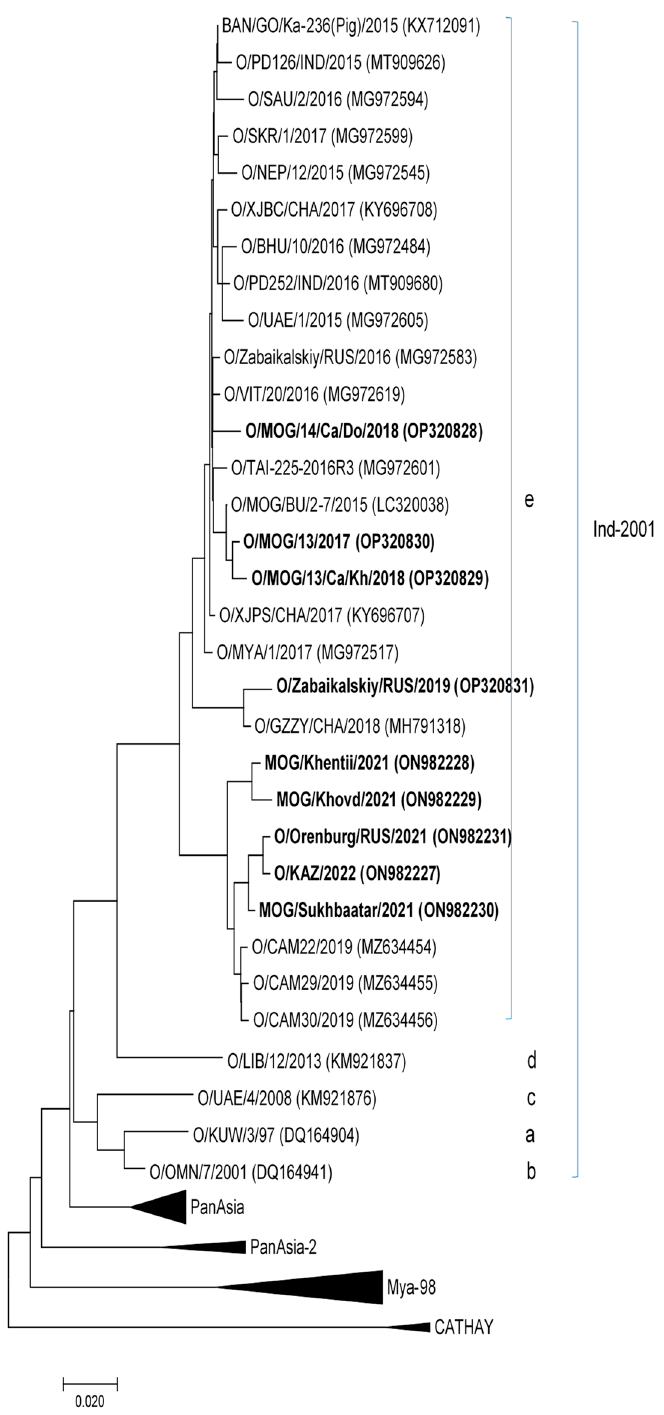
Figure 4. Maximum likelihood tree reflecting the phylogenetic relationship among Russian, Kazakhstan, and Mongolian foot-and-mouth disease viral isolates collected in 2021 and 2022 on the basis of full-length VP1 gene sequences. The studied isolates are in bold.